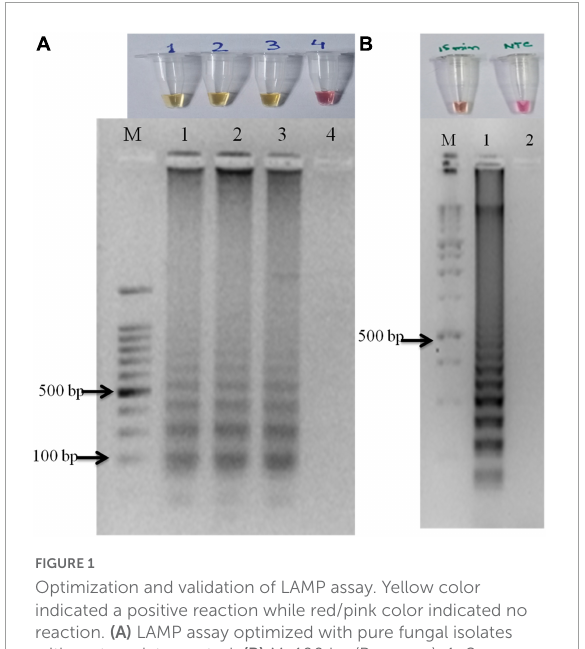
FIGURE1 Optimization and validation of LAMP assay. Yellow color indicated a positive reaction while red/pink color indicated no reaction. (A) LAMP assay optimized with pure fungal isolates with no template control. (B) M: 100 bp (Promega); 1: S. oryzae NAIMCC-F-01633; 2: No Template control. The assay time was kept at 15 minutes.